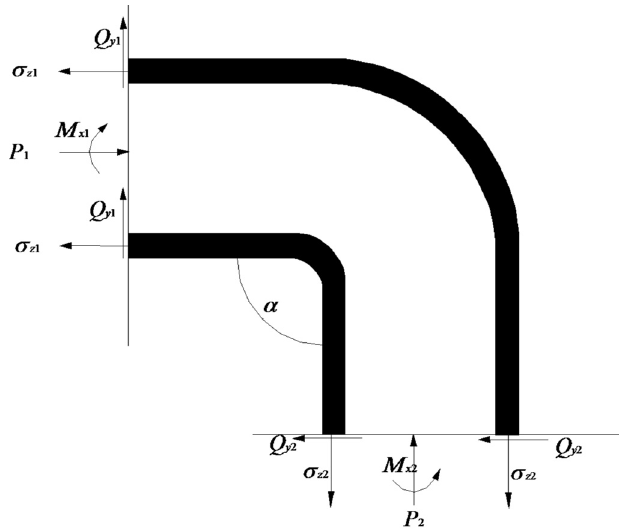
Figure 2. Definition sketch of the junction coupling in elbow.